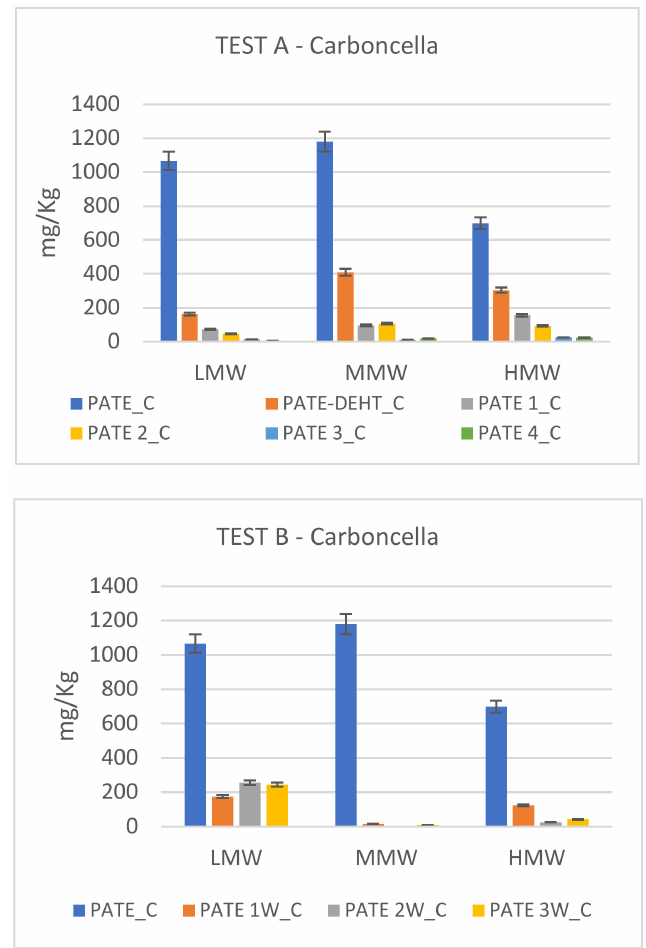
Figure 3. Secoiridoid profile modification in Carboncella cv. during chemical debittering (Test A) and microbial fermentation (Test B). Data, expressed in mg / kg, are the mean of duplicate analyses and the coe ffi cient of variation is <